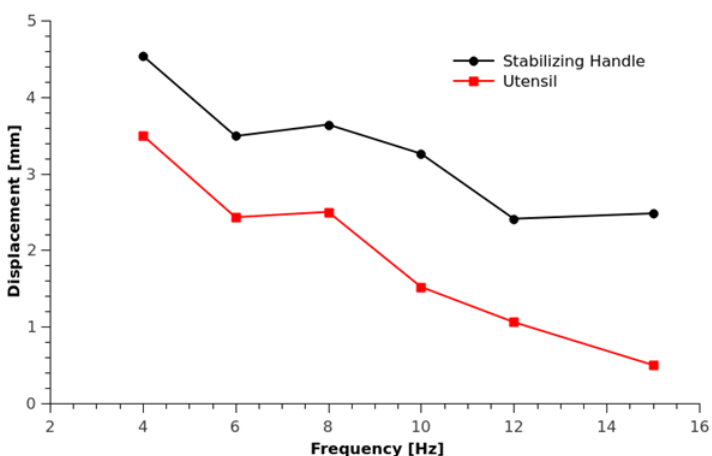
Figure 8. Measured vibration displacement of the stabilizing handle and the vibration of the utensil attachment induced by a shaker at different stimuli